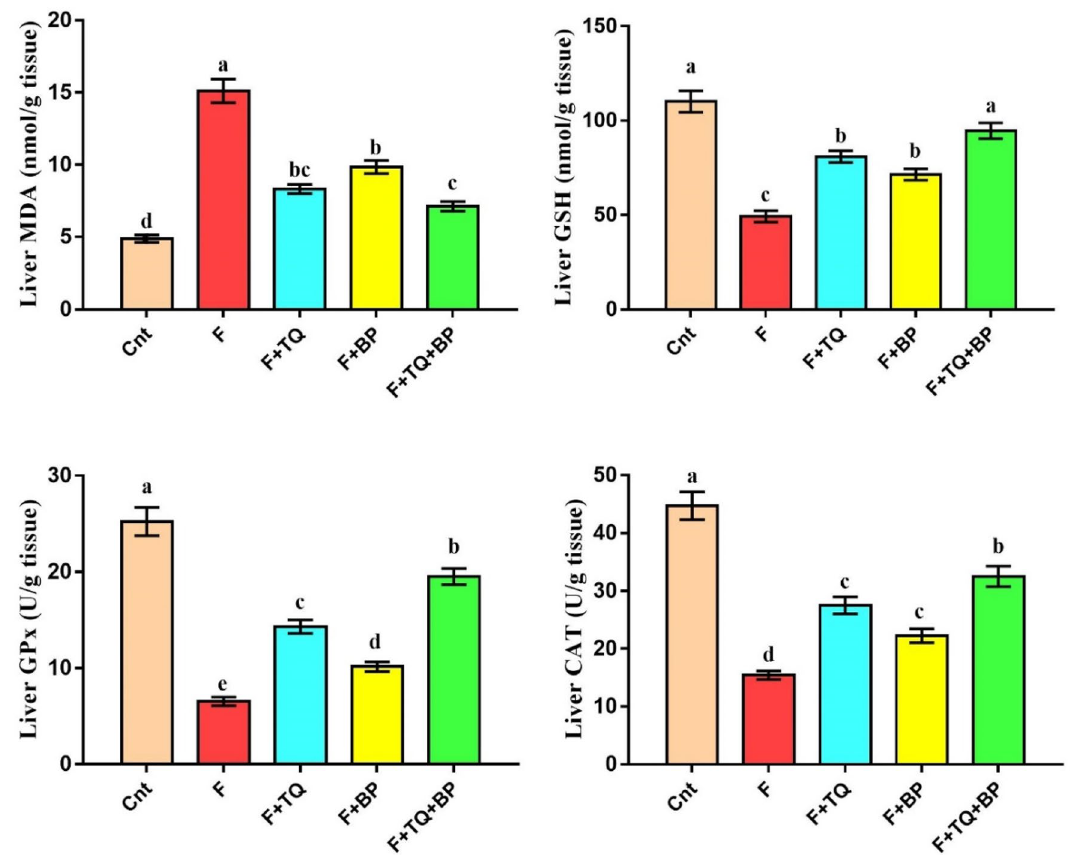
Figure 1. Effect of TQ and/or BP treatment on oxidative stress (MDA) and antioxidant status (GSH, GPx, and CAT) in rat liver. Values are expressed as mean ± SEM (n = 7/group). Columns carrying different letters [a (the highest value) – e (the lowest value)] are significantly different at p < 0.05. All groups were compared to each other. Cnt: control group (G1); F, Fluvastatin-treated group (G2); F + TQ, Thymoquinone-treated group (G3); F + BP, Bee pollen-treated group (G4); F + TQ + BP, co-treated group (G5). (GraphPad Prism 8, https:// www. graph pad. com/ scien tific- softw are/